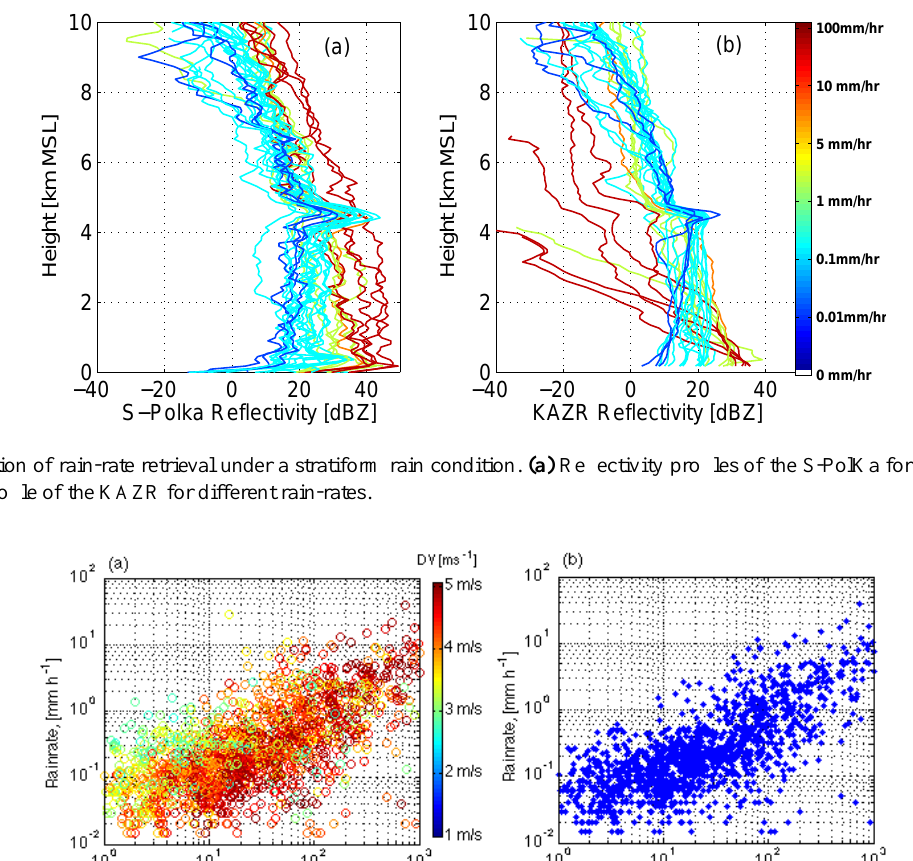
118 out of 3098 total rain cases (i.e., 1 min rain profiles)